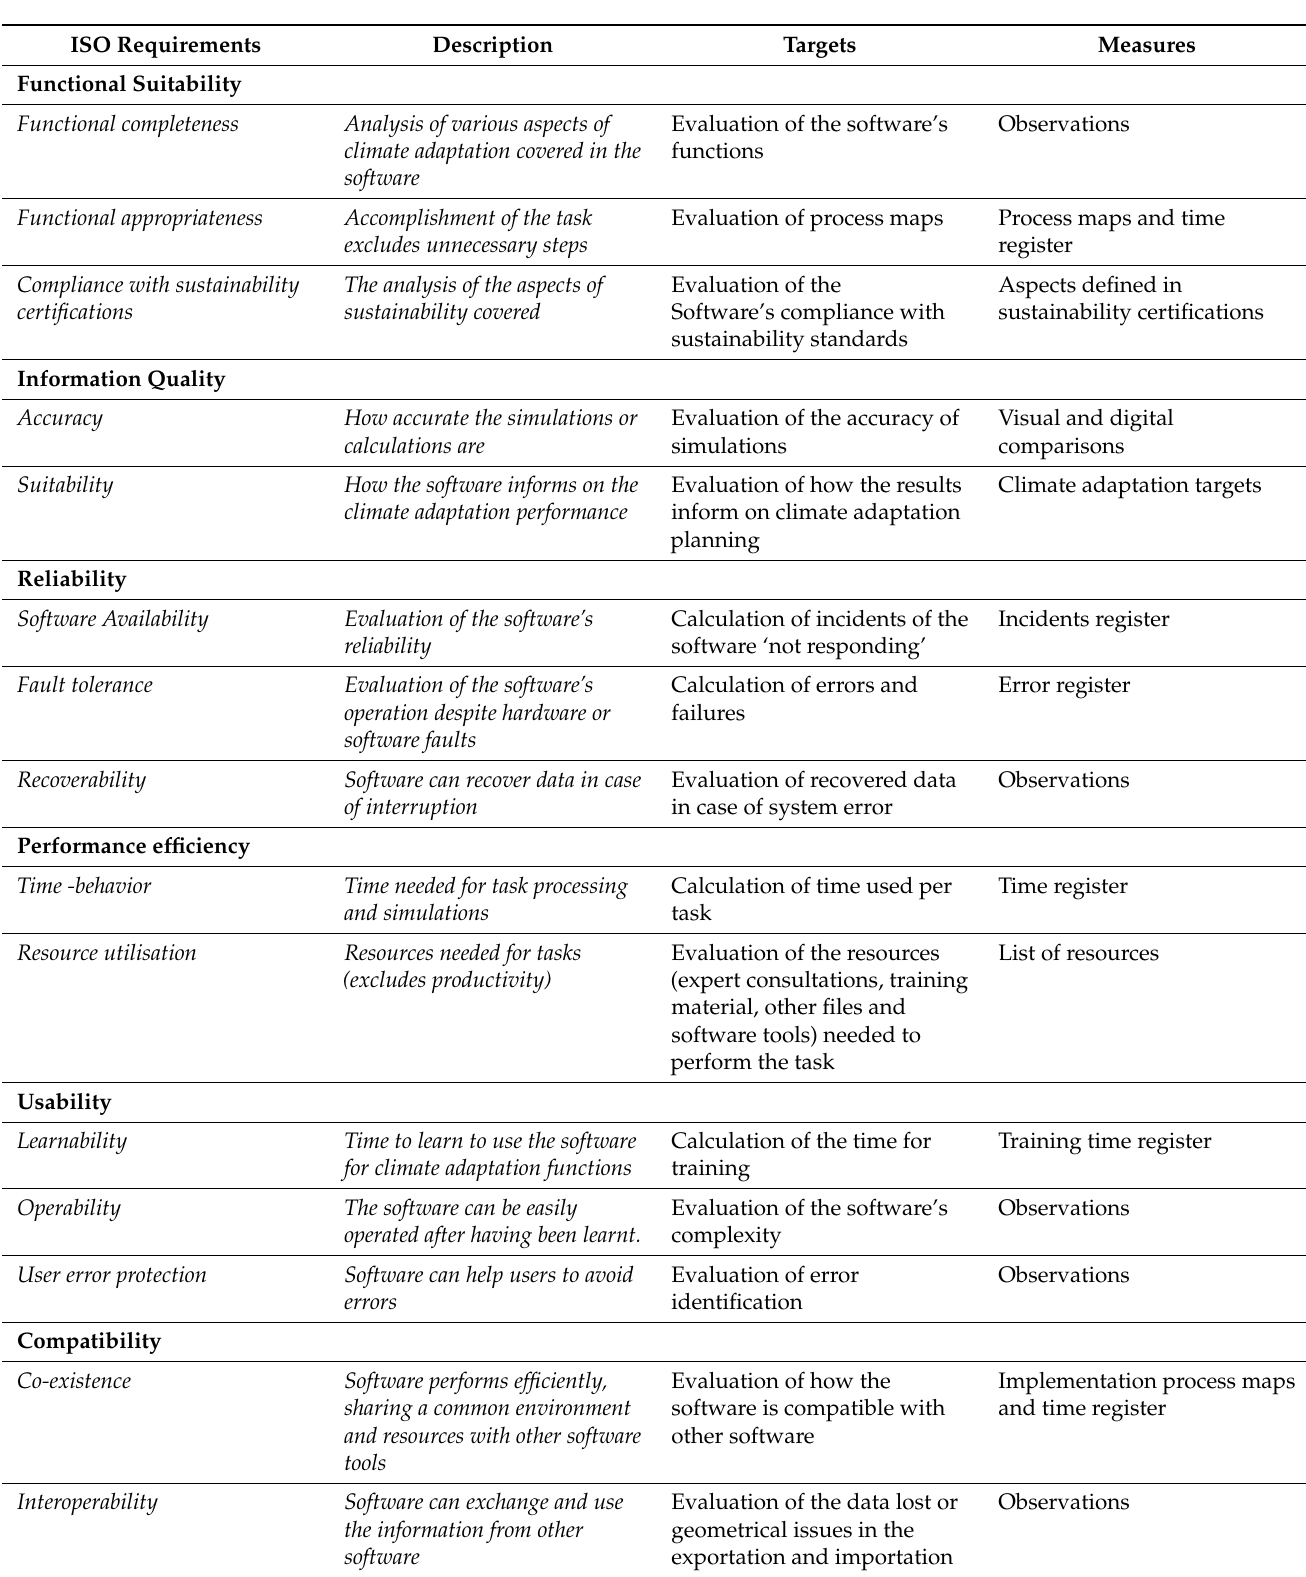
Table 1. Software evaluation framework for climate adaptation software based on ISO 25010 standard (source: